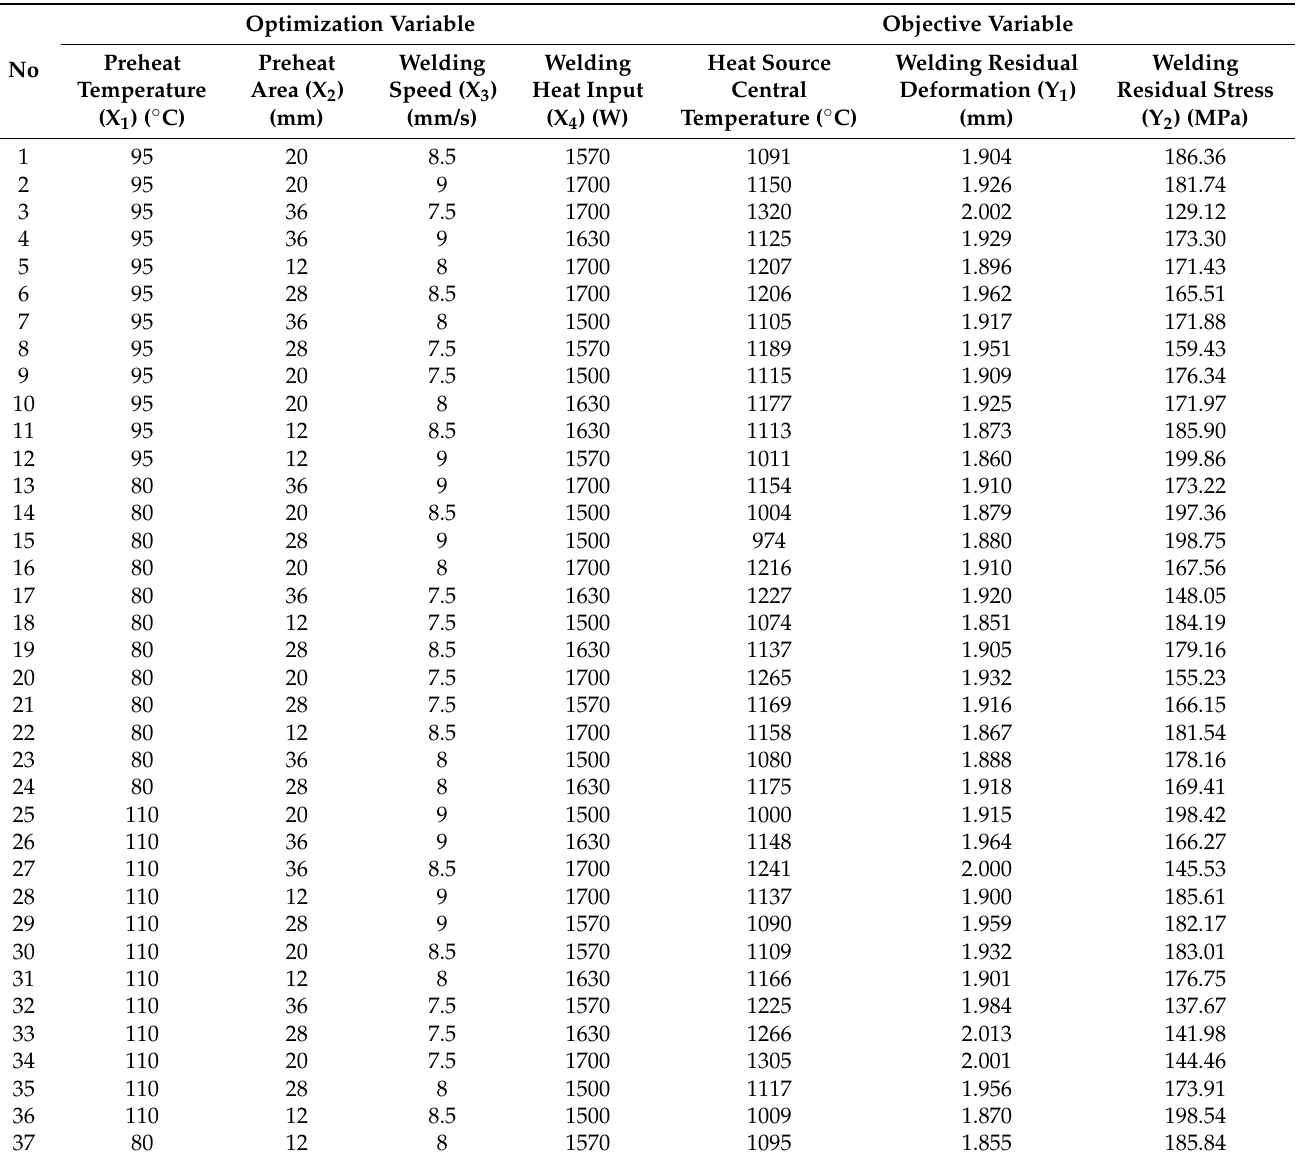
Figure 8. Diagram of the T-joint used in OLHS plans. Table 4. OLHS Plans and Results.